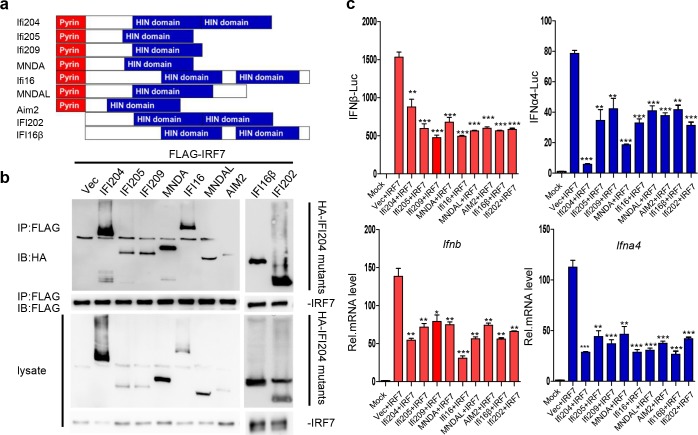
Conserved function of p200 family proteins in the inhibition of type I IFNs responses.(A) Schematic diagram of the domain structure of p200 family proteins. (B) Co-immunoprecipitation (IP, with anti-Flag) and immunoblot (IB, with anti-HA) analysis of HEK293T cells that were transfected with plasmids encoding Flag-IRF7 and HA-(IFI204, IFI205, IFI209, MNDA, IFI16, MNDAL, AIM2, IFI202 and IFI16β) for 24 hrs. Cell lysate was analyzed by immunoblot with anti-Flag and anti-HA antibodies. (C) Dual luciferase assays for analyzing the promoter activity of IFNβ or IFNα4 in Irf3−/−Irf7−/−MEFs co-transfected with IFNβ or IFNα4 promoter luciferase reporter plasmids and the indicated plasmids, respectively. The Renilla expression plasmid (pRL-TK, 10 ng) was co-transfected as an internal control (upper graphs). qRT-PCR analysis of Ifnb or Ifna4 in Irf3−/−Irf7−/− MEFs transfected with the indicated plasmids (lower graphs). 24 hrs post-transfection, cells were treated with SeV for 12 hrs. *P < 0.05, **P < 0.01 and ***P < 0.001. Data are representative of three independent experiments (mean ± SD in C).